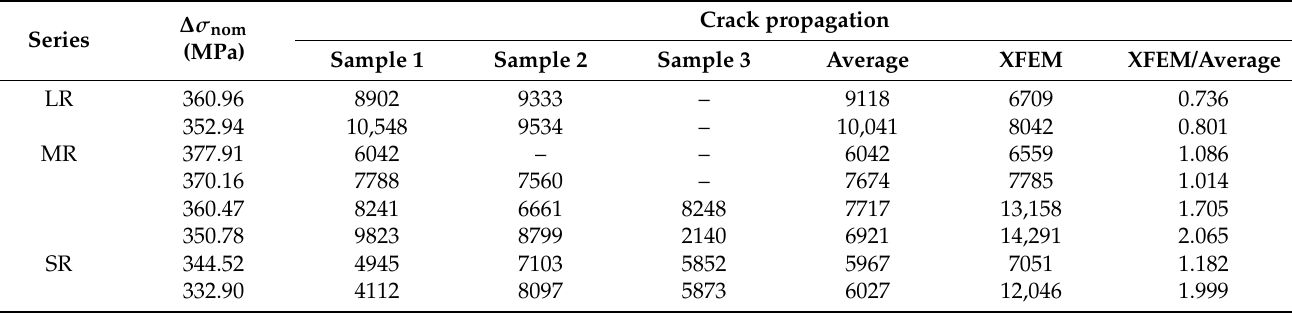
Table 5. Comparison of predicted and experimental fatigue crack propagation